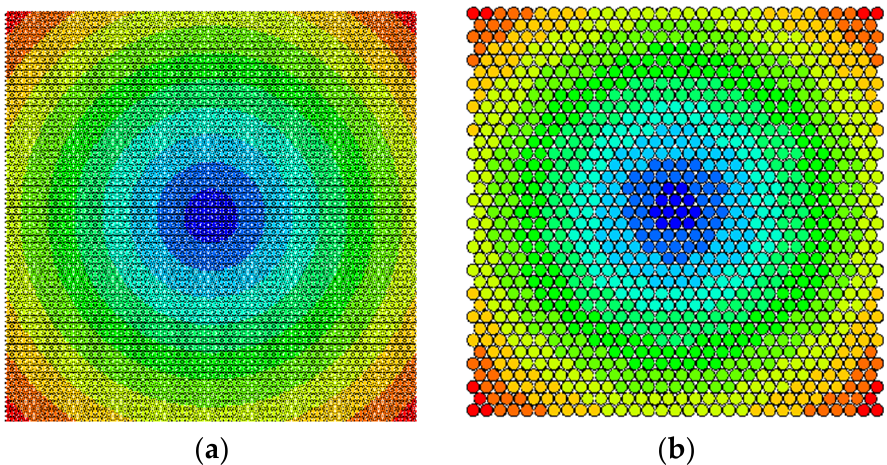
Figure 2. The initial discrete element model of the concrete sample. ( a ) 1 mm particle size. ( b ) 5 mm particle size.